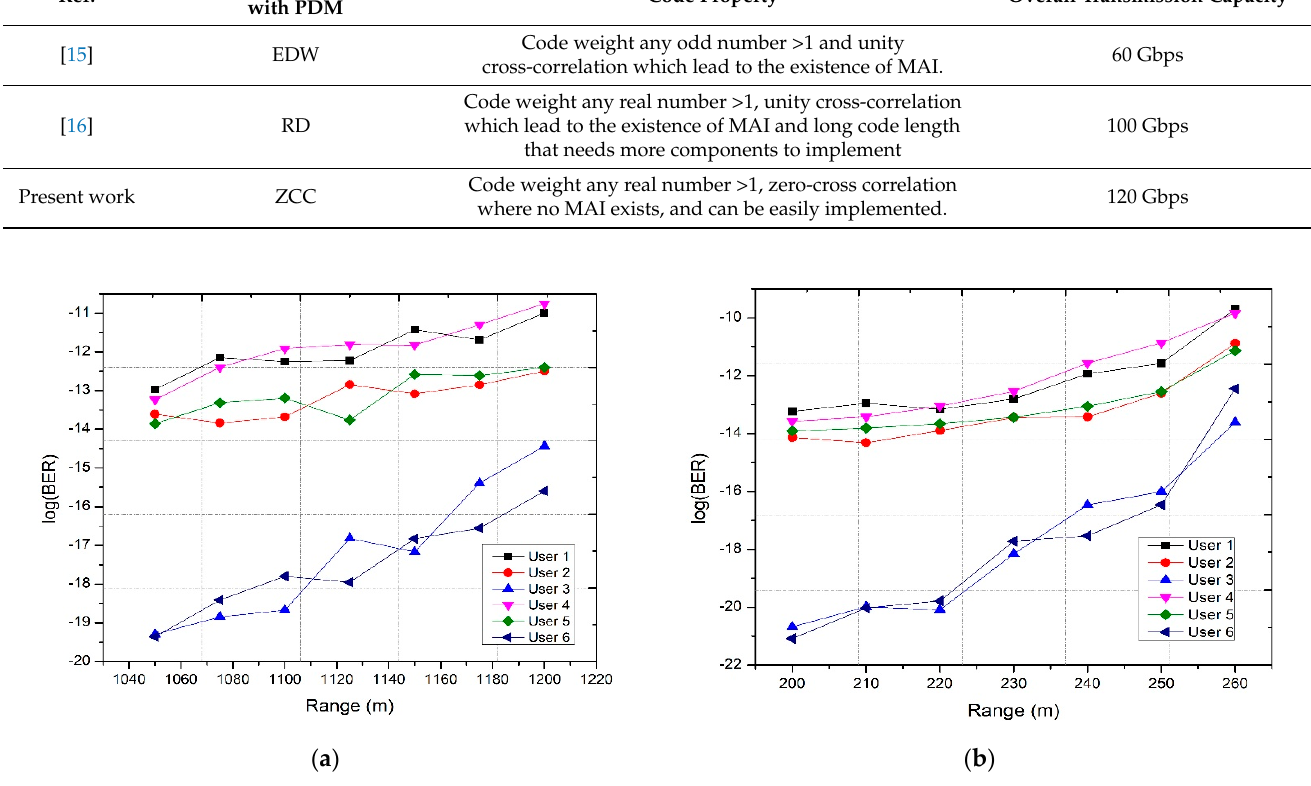
Figure 8. log(BER) for PDM-SAC-OCDMA-enabled FSO transmission versus range under ( a ) WSF and ( b ) DSF.